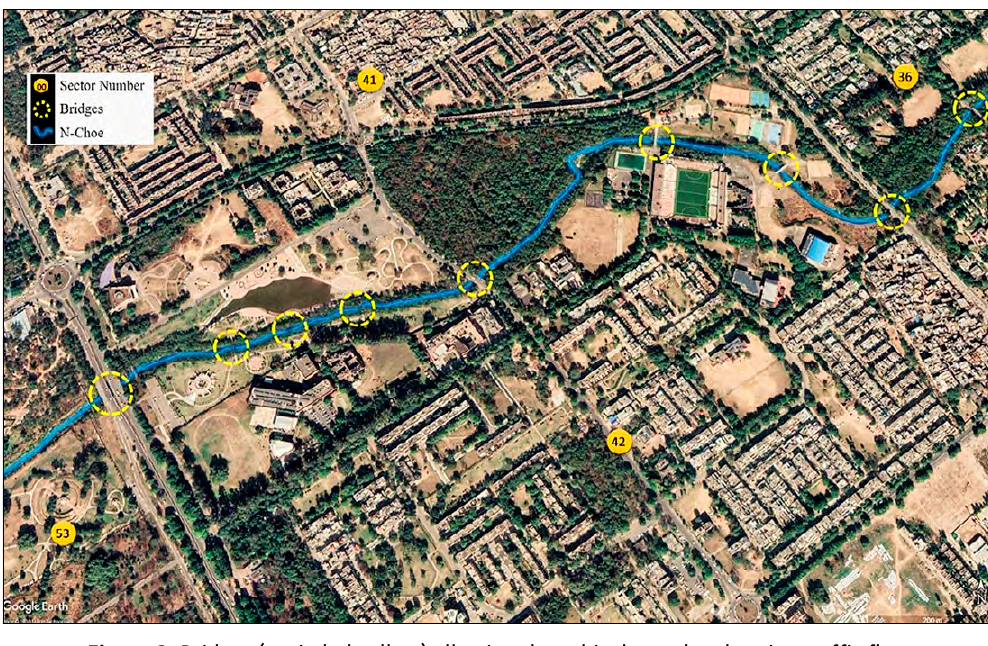
Figure 3. Bridges (encircled yellow) allowing the vehicular and pedestrian traffic flow without disturbing the streamflow in N-choe Source: Developed by authors from the Google Earth imagery